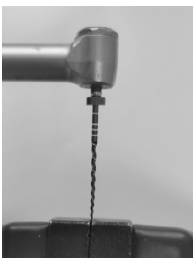
Figure 1. Device for cyclic fatigue resistance tests.